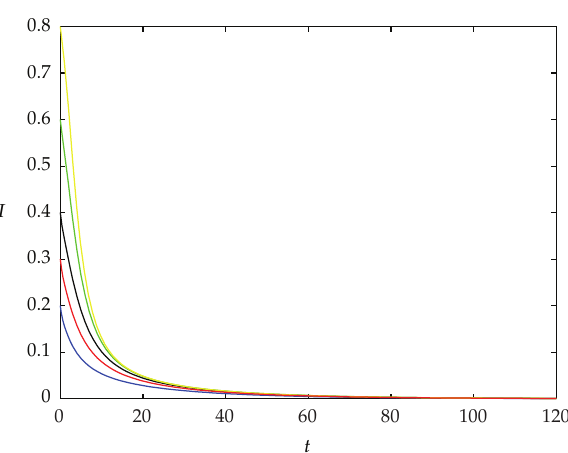
Figure 2: Time series of I (cid:3) t (cid:4) with di ff erent initial values and parameters ρ (cid:7) 0 . 3 , μ (cid:7) 0 . 2 , β (cid:7) 1 . 5 , α (cid:7) 1 , r (cid:7) 0 . 5 , d (cid:7) 0 . 2 , ω (cid:7) 0 . 1 , and τ (cid:7) 1.